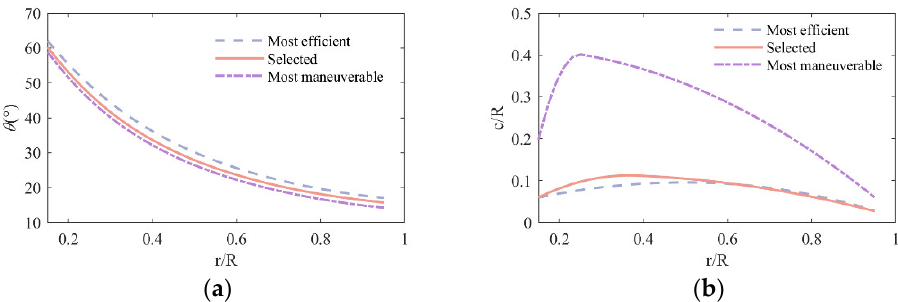
Figure 21. Selected comprehensive optimal FPP.